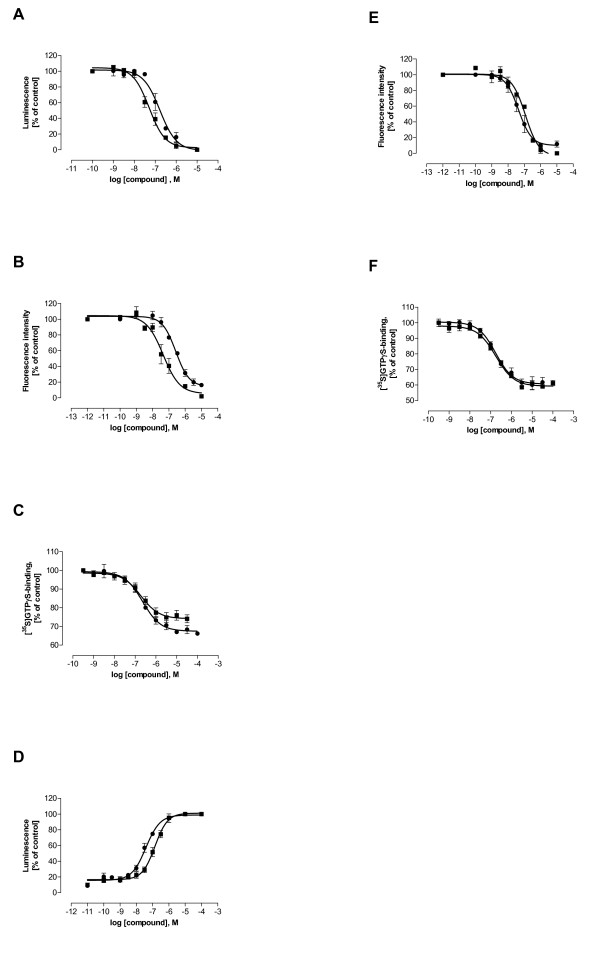
Functional characterisation of LE404 (■) and LE410 (●) at hD1 (A, B, C) and hD2L receptors (D, E, F). A Inhibition by LE404 and LE410 of 100 nM SKF38393-stimulated accumulation of intracellular [cAMP]. Data shown are means ± SEM of at least four determinations assayed in triplicate. B Inhibition by LE404 and LE410 of 100 nM SKF38393-stimulated increase in intracellular [Ca2+]. Data shown are means ± SEM of at least four determinations assayed in triplicate. C Inhibition by LE404 and LE410 of G-protein activation obtained by 1 μM dihydrexidine-stimulation. Data shown are means ± SEM of two independent experiments assayed in duplicate. D Inhibition by LE404 and LE410 of 100 nM quinpirole-stimulated decrease of intracellular [cAMP] in the presence of 10 μM forskolin. Data shown are means ± SEM of at least four determinations assayed in triplicate. E Inhibition by LE404 and LE410 of 30 nM quinpirole-stimulated increase in intracellular [Ca2+]. Data shown are means ± SEM of at least four determinations assayed in triplicate. F Inhibition by LE404 and LE410 of G-protein activation obtained by 10 μM quinpirole-stimulation. Data shown are means of two independent experiments assayed in duplicate.